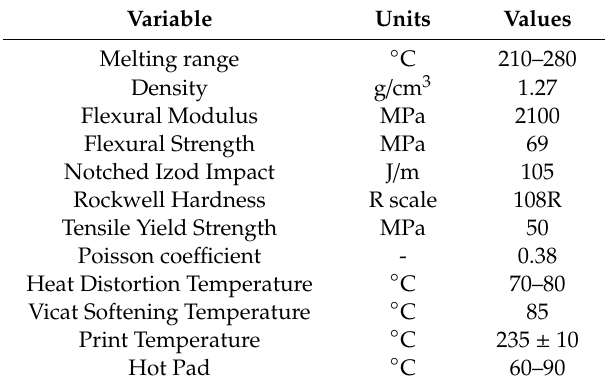
Table 5. Physical, mechanical and technological properties of polyethylene terephthalate glycol (PETG).